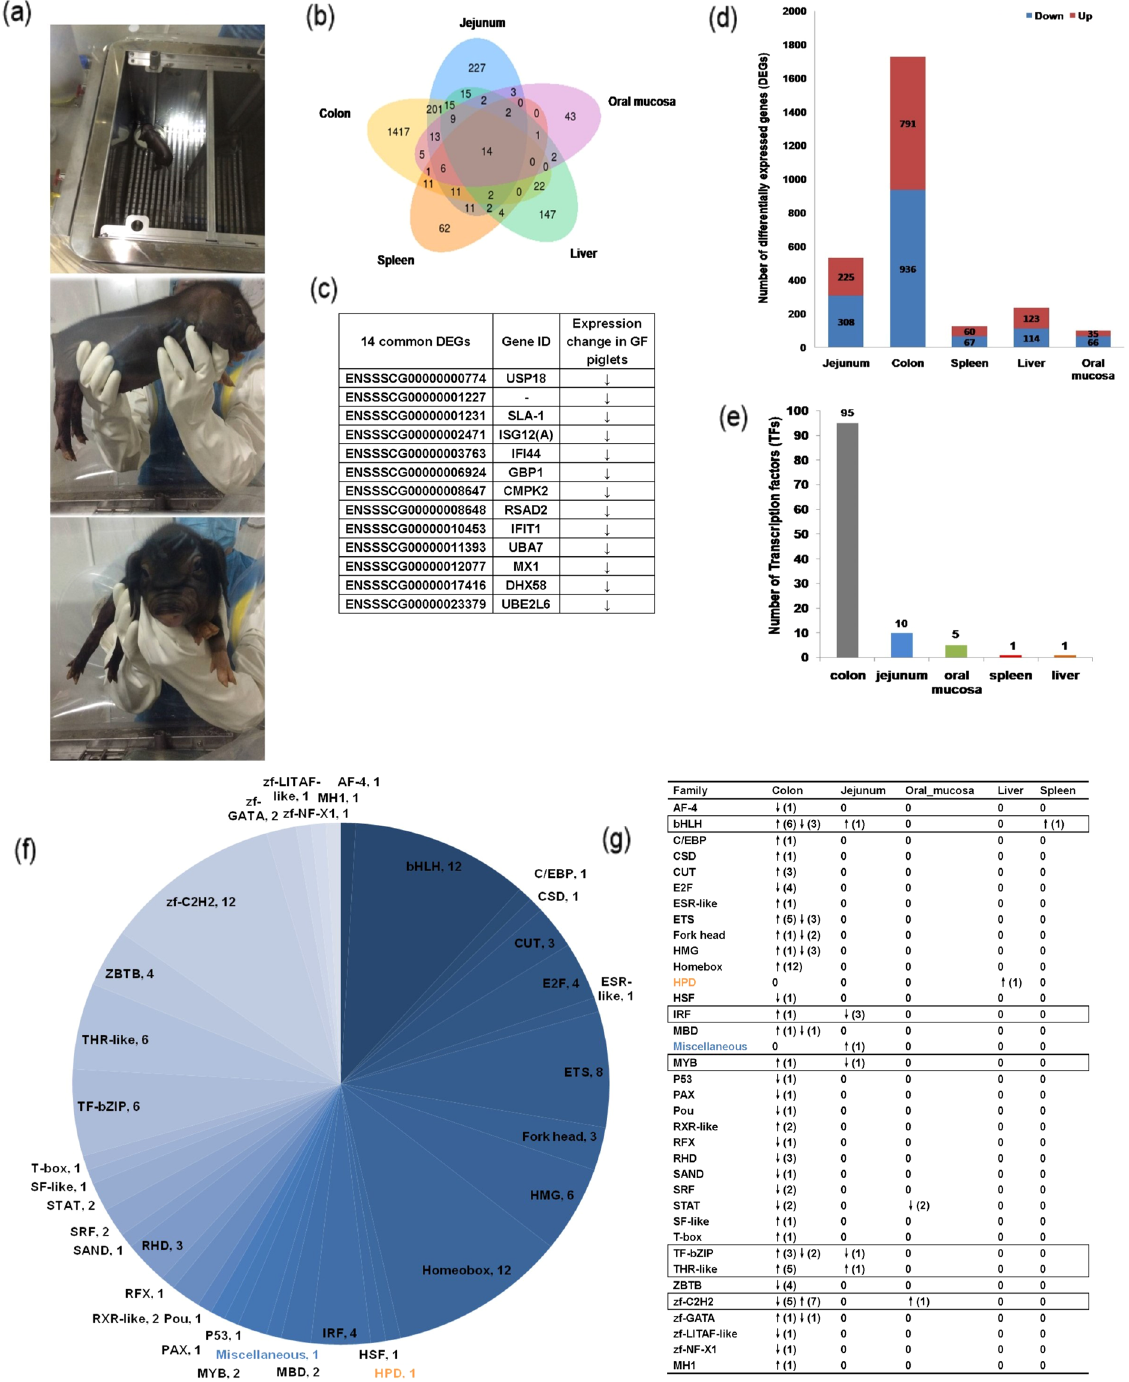
Figure 1. Differential expression of genes and transcription factors (TFs). ( a ) Germ-free piglets in sterile isolators. Distribution of ( b ) differentially expressed genes (DEGs) and ( c ) common DEGs in colons, jejuna, spleens, livers, and oral mucosae of the eight piglets. ( d ) Distribution of up- and downregulated DEGs across all tissues. The ( e ) number and ( f ) distribution of TFs, transcription co-factors, and chromatin remodeling factors (CRFs). ( g ) The distribution of TFs within each tissue. Orange indicates TFs only expressed in the liver, blue indicates TFs only expressed in the jejunum. Black box indicates TFs expressed in two or more tested